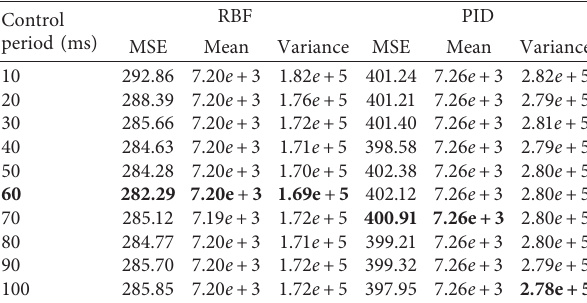
Table 10: Variation of MSE, output power mean, and variance with the control